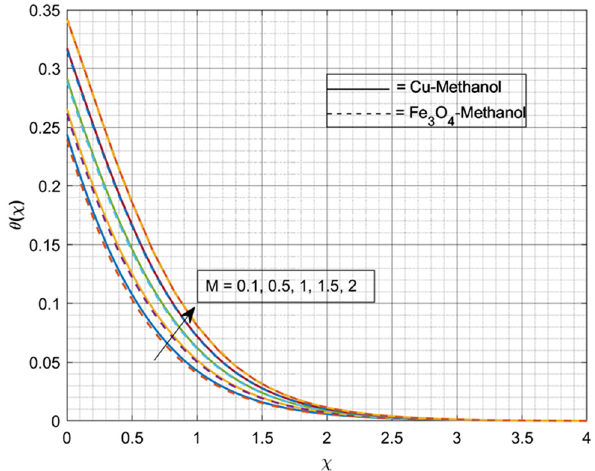
Figure 10: Sway of M on θ .